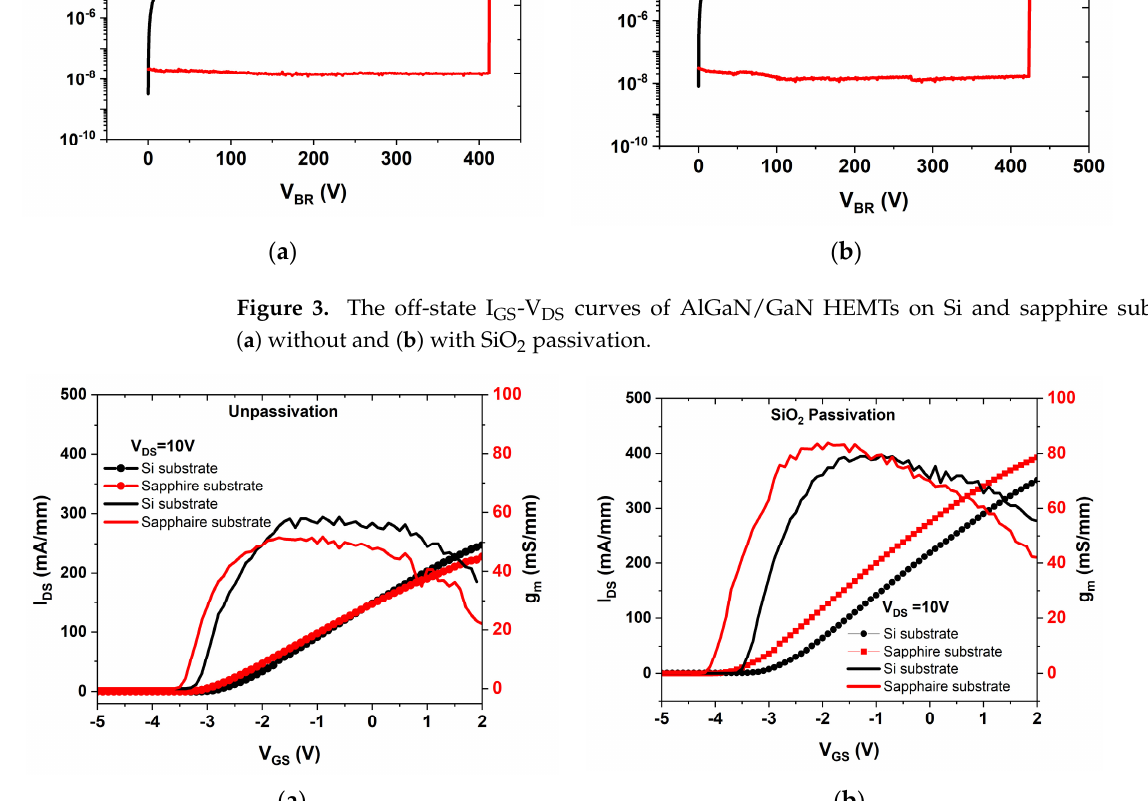
Figure 4. The I DS ‐ V GS transfer curves and transconductance curves of AlGaN/GaN HEMTs on Si and Figure 4. The I DS -V GS transfer curves and transconductance curves of AlGaN/GaN HEMTs on Si sapphire substrates ( a ) without and ( b ) with SiO 2 passivation. and sapphire substrates ( a ) without and ( b ) with SiO 2